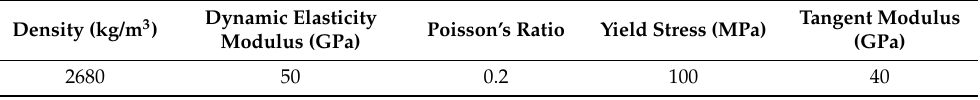
Table 3. Main physical and mechanical parameters of surrounding